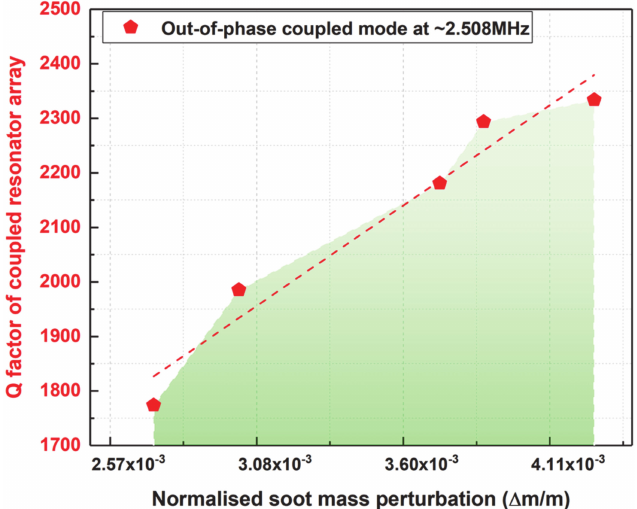
Figure 10. Quality factor of the coupled MEMS resonator array for the second 20 min of soot particle impaction at di ff erent time intervals on one of the coupled